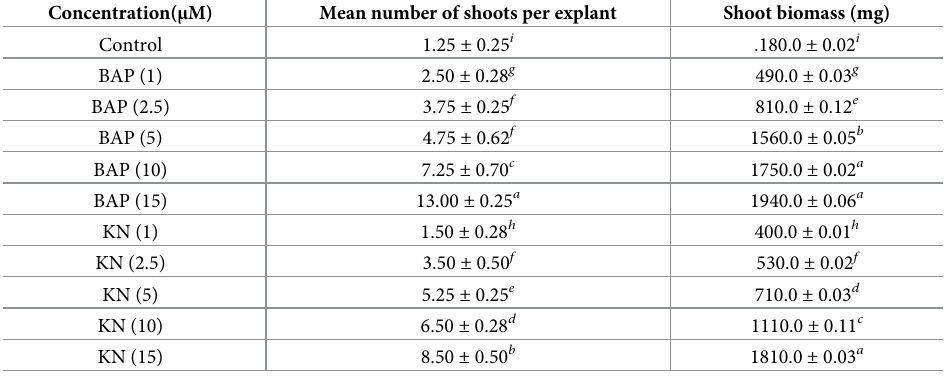
Table 2. Effect of benzyl amino purine (BAP) and kinetin (KN) on multiple shoot proliferation on agar gelled MS